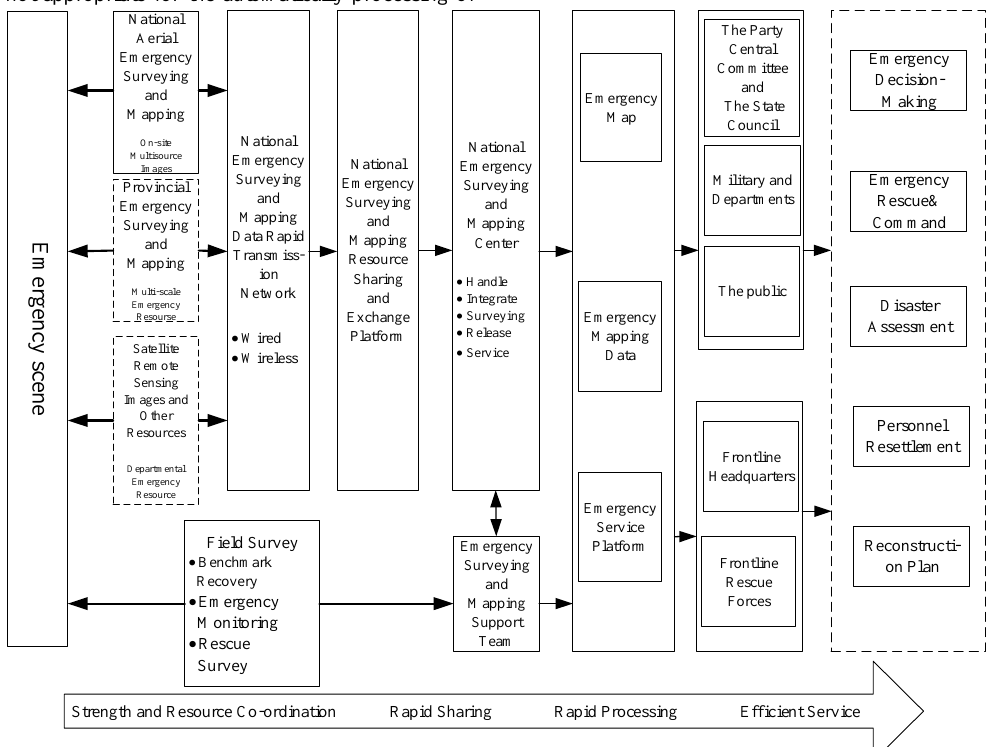
Figure 1. National emergency surveying and mapping business flow